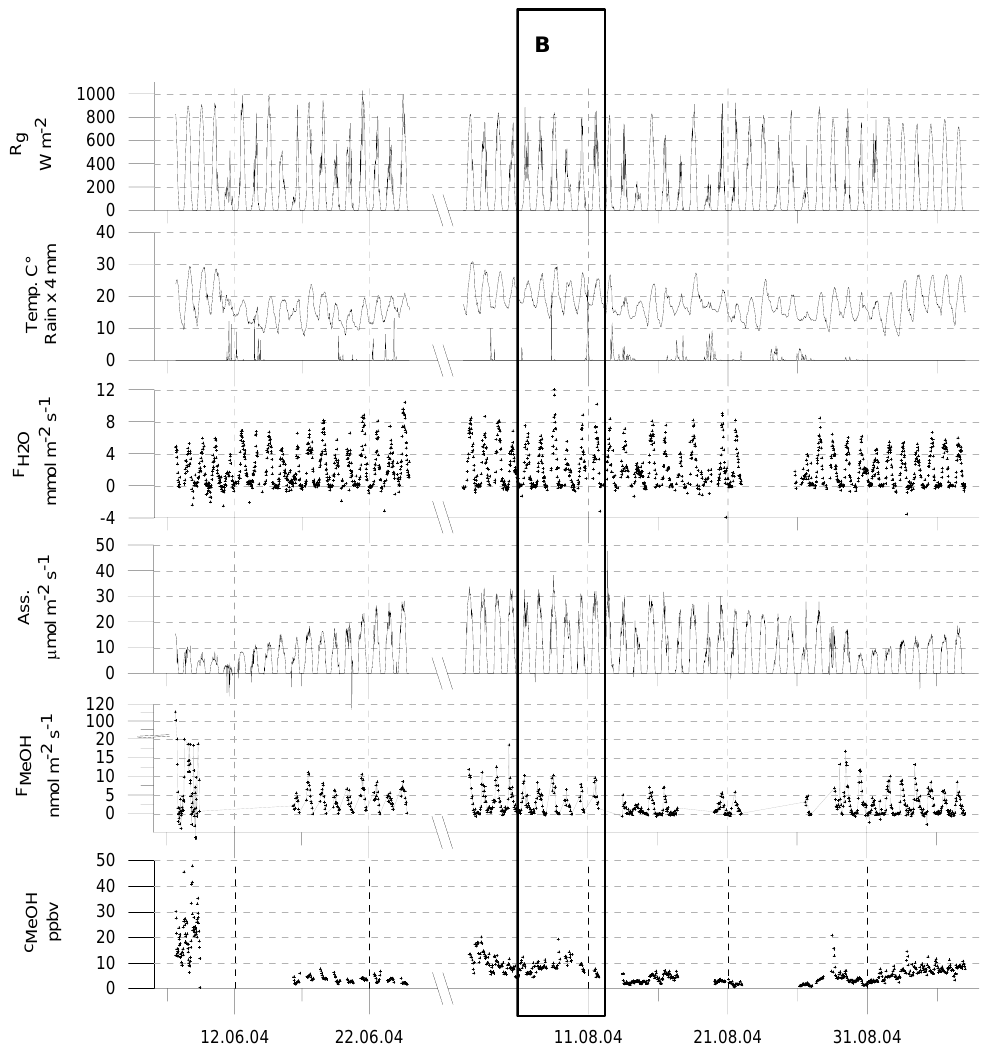
Fig. 7. Time series measured above the extensive grassland (07.06–07.09.2004), from the top to the bottom: Global radiation* ( R g ) , ) , assimilation (Ass.), methanol flux ( F MeOH ) , and methanol air temperature* (Temp.), rainfall*, water vapour flux ( F H 2 O